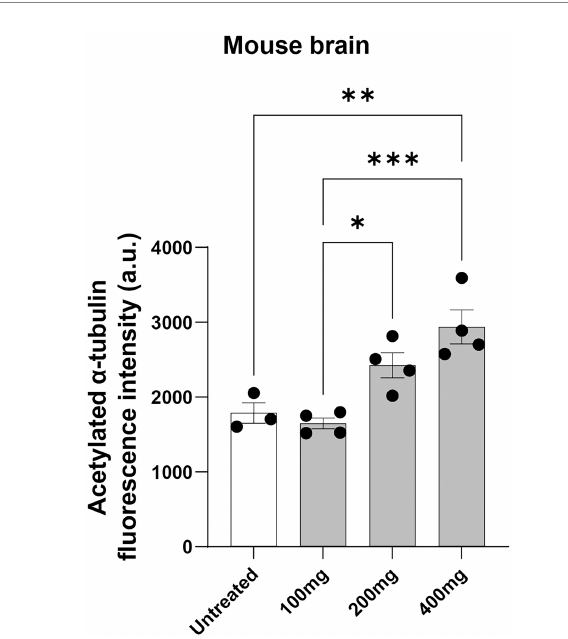
FIGURE 4 Acetylated α -tubulin levels in noscapine treated human PBMCs. Acetylated α -tubulin was measured in human PBMCs treated with noscapine ( in vitro ) at 10 μ M for 1 h. Student’s t-test confirmed a significant noscapine treatment effect on acetylated α -tubulin levels ( **** p < 0.0001). N = 8 PBMC samples per untreated and noscapine treated groups. Mean ±